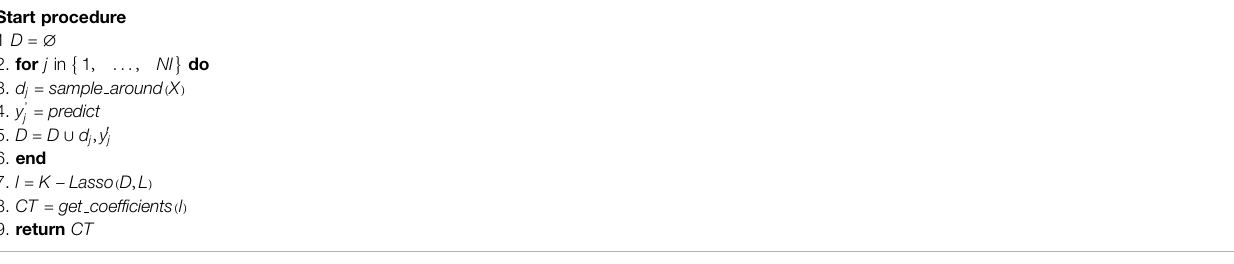
TABLE 1 | Detailed work fl ow to develop LIME for prediction explanation. Inputs SVM represents an established black box model X stands for an observation point that needs to be explained NI represents several randomly generated observations, while L is the length of interpretation Output: CT stands for a set of contribution of battery manufacturing parameters of interest on the predictions of the observation point X .